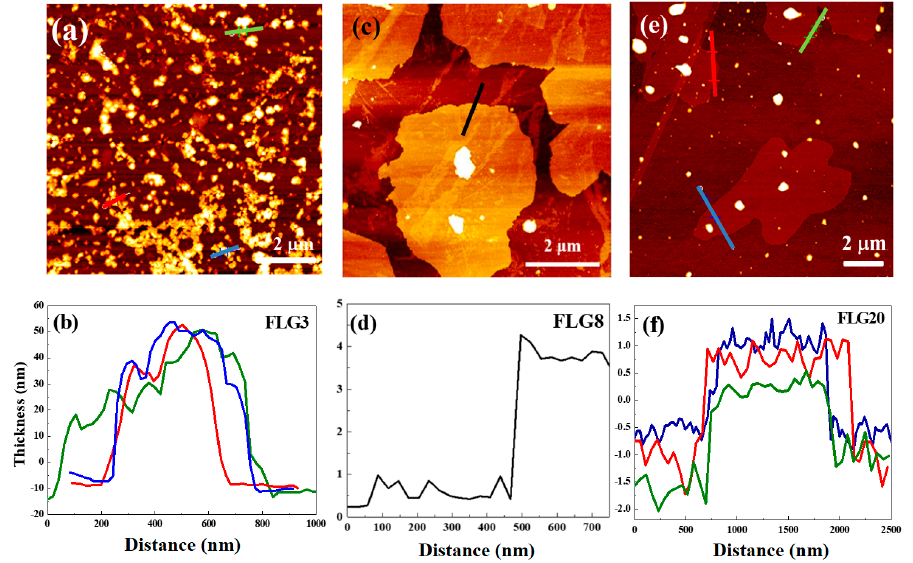
Figure 2. Atomic force microscopy (AFM) images of ( a ) FLG3, ( c ) FLG8, and ( e ) FLG20. Distribution of the thickness of ( b ) FLG3, ( d ) FLG8, and ( f ) FLG20 calculated from the obtained AFM